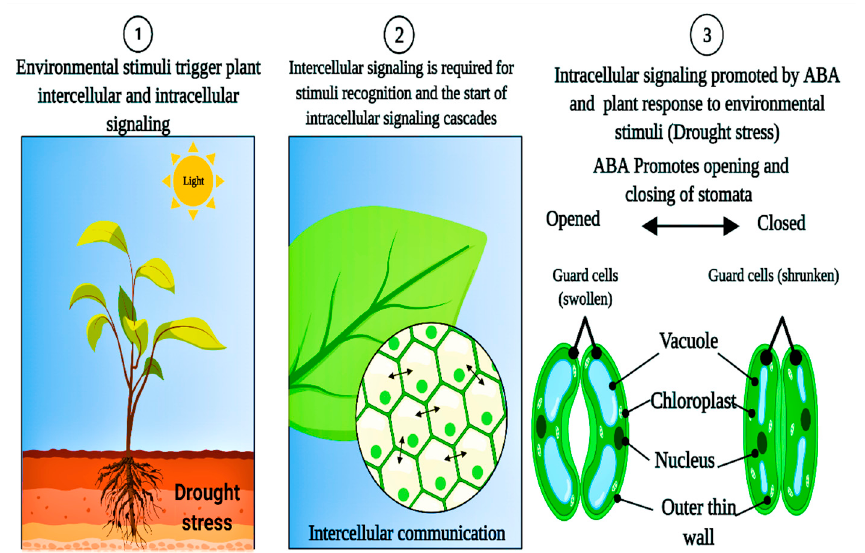
Figure 6. Abscisic acid (ABA) is vital for plant development and stress response. In response to biotic and abiotic stimuli, ABA transfer to guard cells triggers stomatal closure in